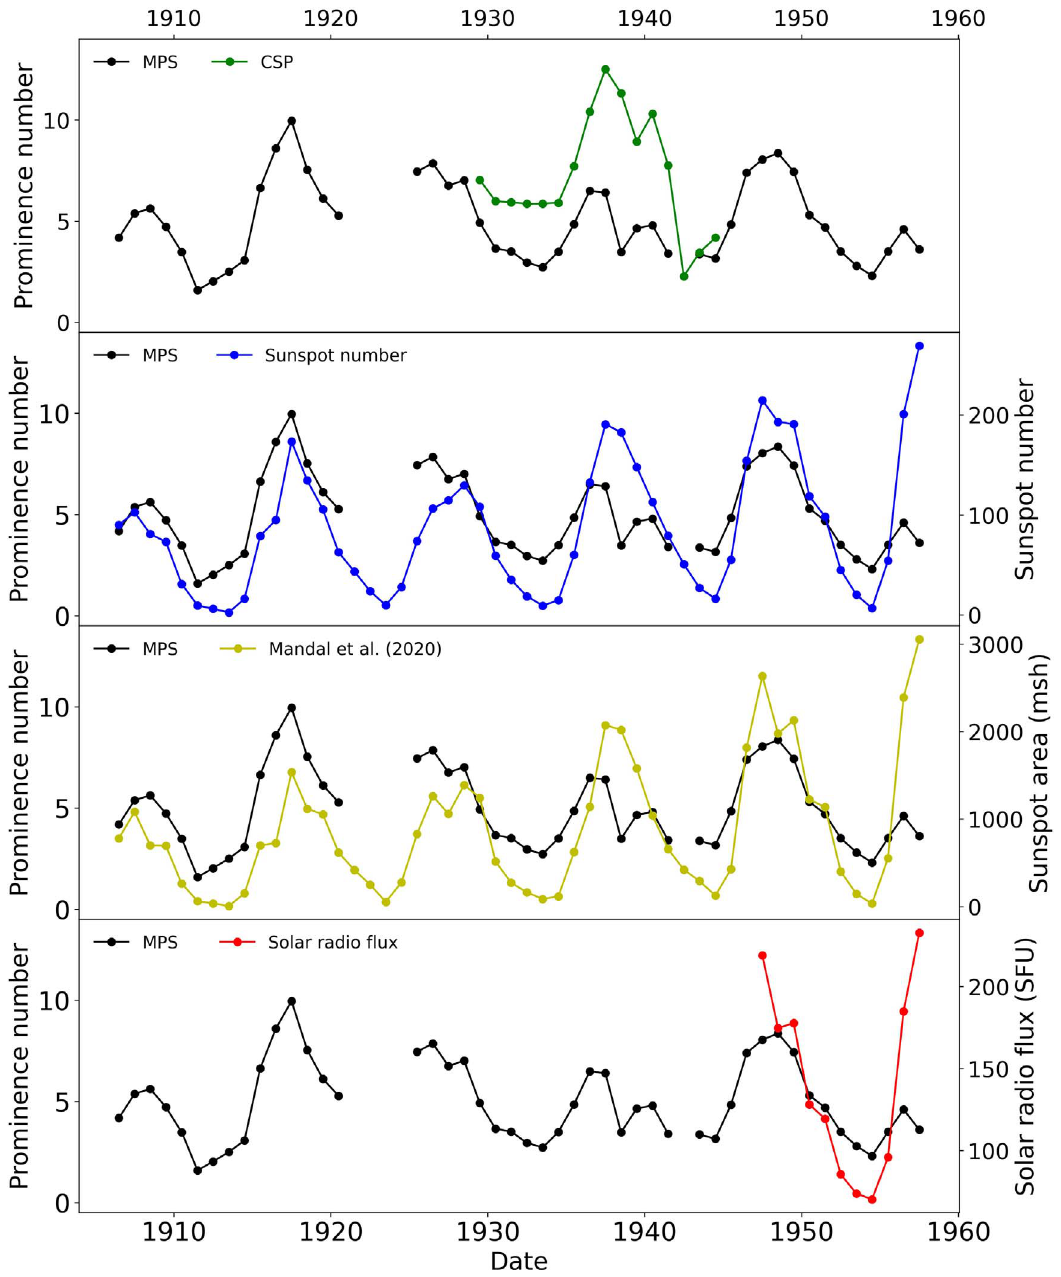
Figure 3. Comparison between the daily mean of the number of prominences recorded at the Madrid Astronomical Observatory for the period 1906 – 1957 (black) and, from top to bottom, the number of prominences recorded at the Astronomical Observatory of the University of Coimbra for the period 1929 – 1944 (dark green), the sunspot number for the period 1906 – 1957 (blue), the sunspot area by Mandal et al. (2020) for the period 1906 – 1957 (yellow), and the solar radio fl ux at 10.7 cm for the period 1947 – 1957